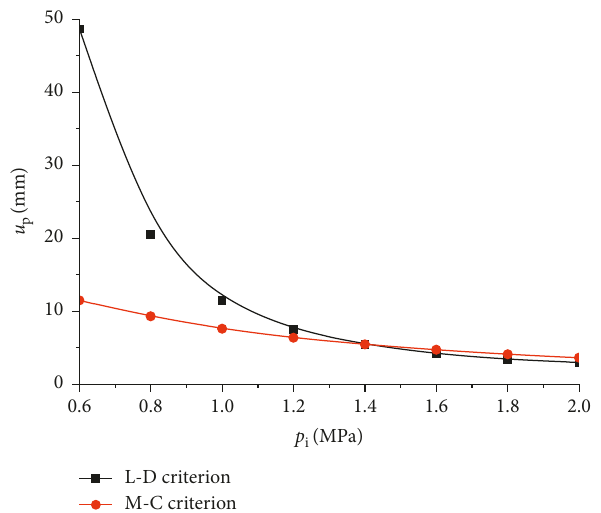
Figure 8: Relation curves between support resistance and plastic zone